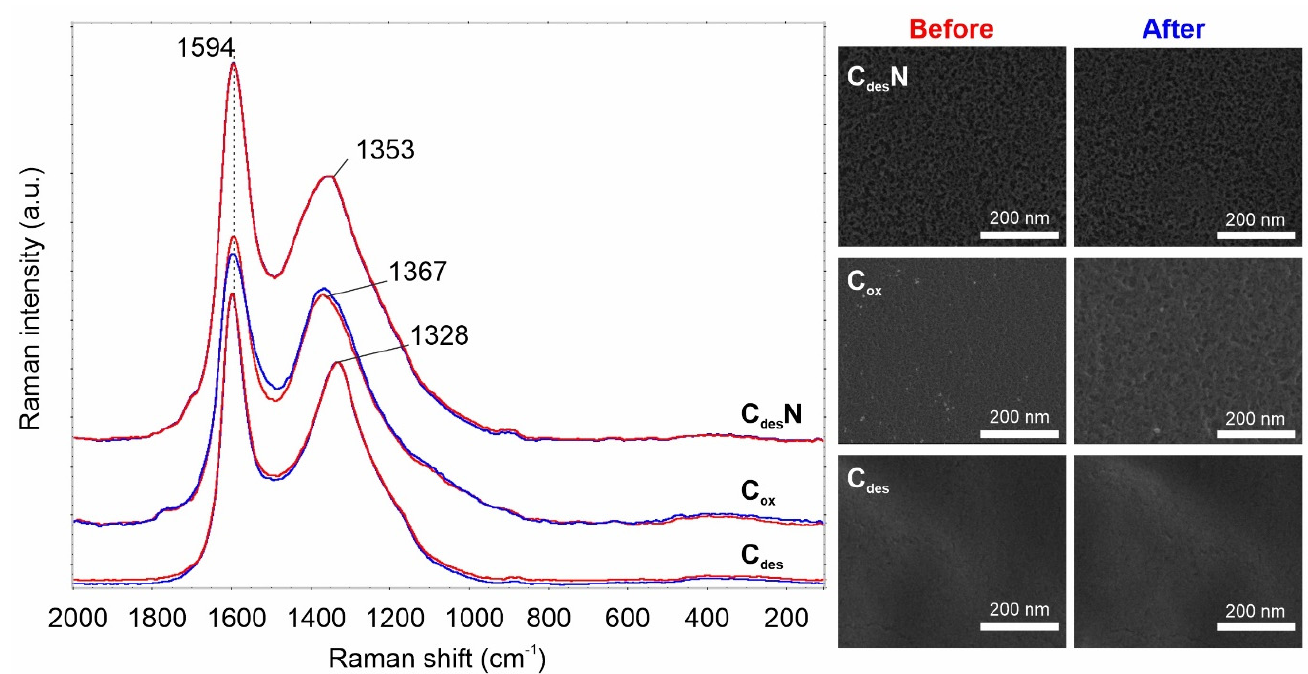
Figure 2. Left panel: FTIR spectra of the gas phase before (a) and after the NH 3 splitting process over tested carbons: (b) no catalyst, (c) C ox , (d) C des , (e) C des N. Right panel: catalytic conversion and selec- tivity of tested systems.